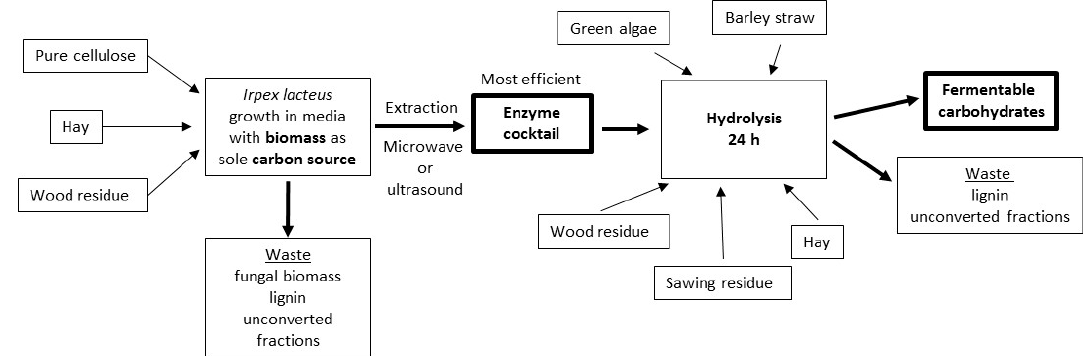
Figure 1. Experimental flow scheme showing the biomass materials used for enzyme production and biomass used for the hydrolysis tests of the most e ffi cient enzyme product obtained after the extraction process adjustment (Section 2.4.). Biomass was not mixed during the experiments.